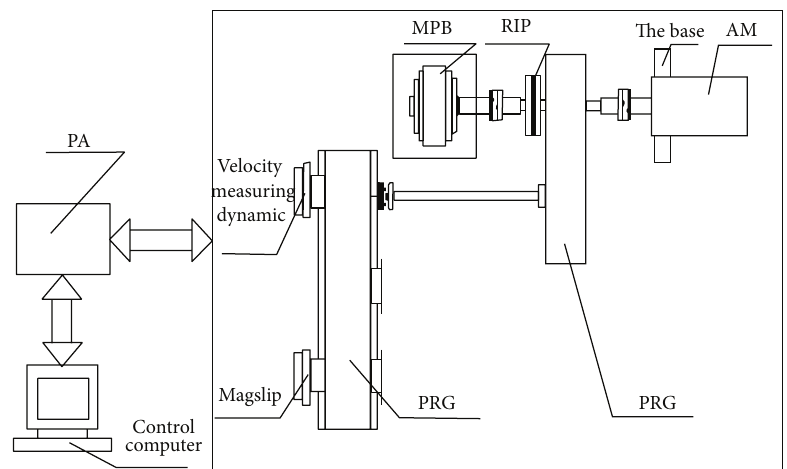
Figure 9: Schematic of the semiphysical simulation platform.